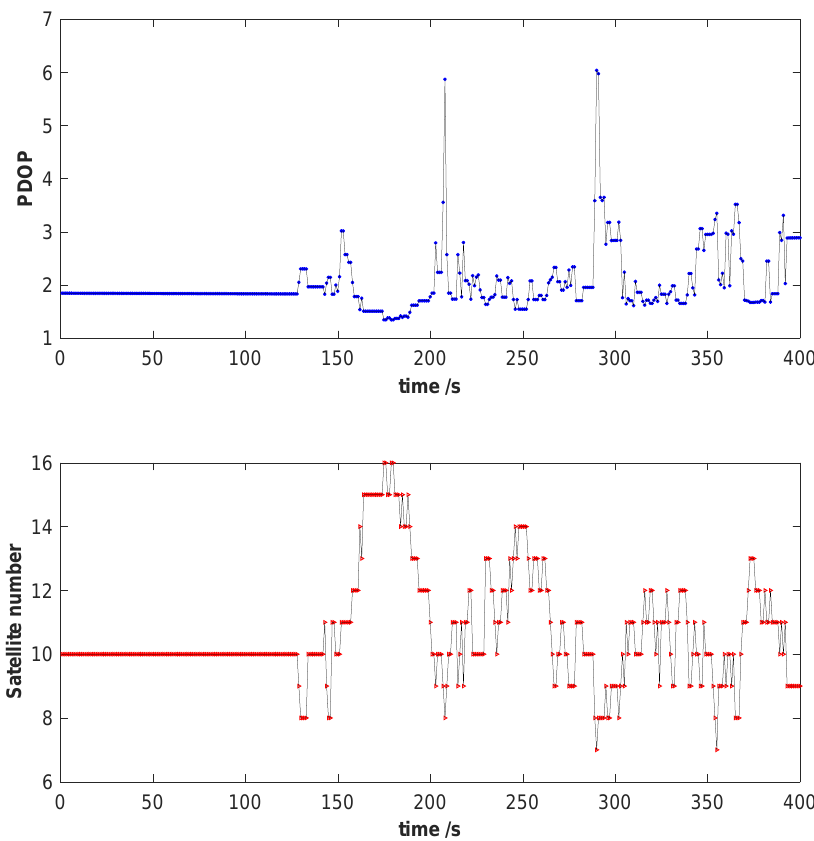
Figure 6. PDOP and the number of satellites during the dynamic test. Figure 7 shows an overview of vehicle trajectories, and shows the difference between the trajectories before and after fault detection and identification based on the VSOM. When one or more faults occurred, the trajectory became deformed. As shown in the figure below, a fault occurred at the 350th second, and the fault caused an abrupt distur- bance. The proposed method was implemented, and the trajectory was not affected by the fault. Obviously, after down-weighting the fault in the estimation process, the trajectory maintained